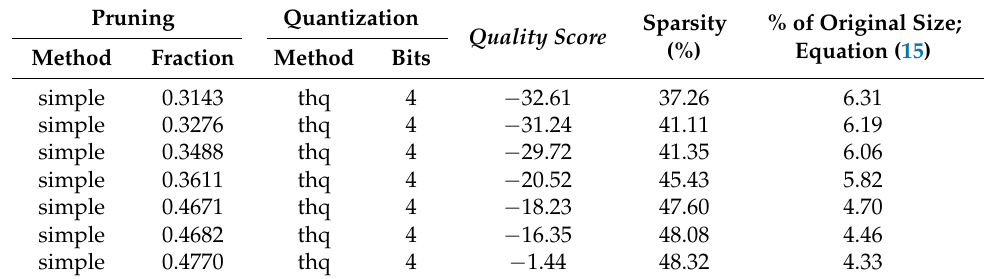
Table A3. [IAP] Results for pruned and quantized model with single retraining epoch added.